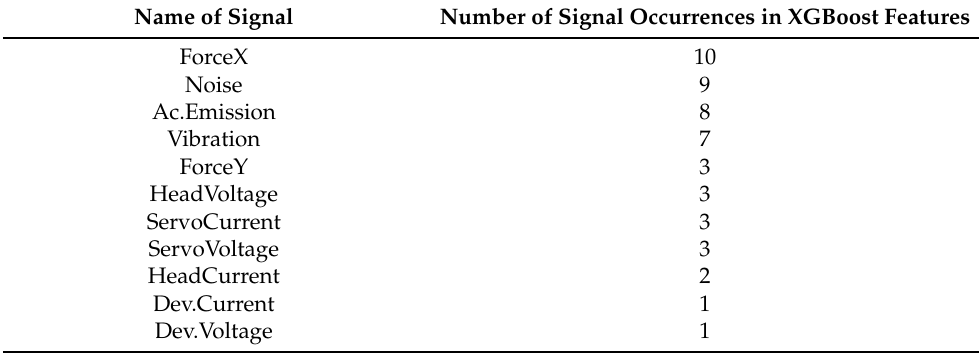
Table 13. Ranking list of the number of signal occurrences in XGBoost